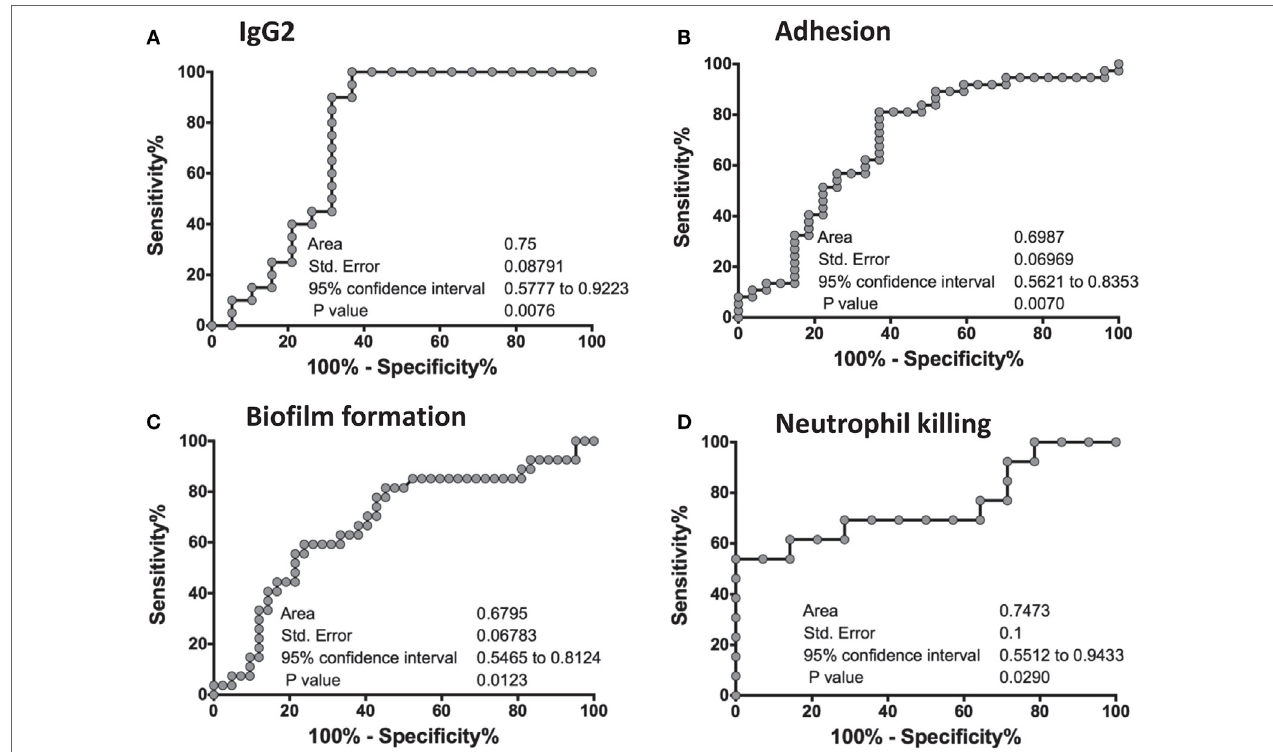
FigUre 6 | Receiver-operating characteristic (ROC) analysis of the in vitro assays. An ROC analyses for four in vitro studies was performed on GraphPad Prism software, where a graph was generated of 100% − (minus) Specificity % vs. Sensitivity % for each of the assays: IgG2 titers (a) , adhesion (B) , biofilm formation (c) , and neutrophil killing (D) . For each graph, an area under the curve (AUC), standard error of the ROC curve, as well as the 95% confidence interval are reported. A p -value of < 0.05 in each of the ROC curves concludes that the results are significant, and